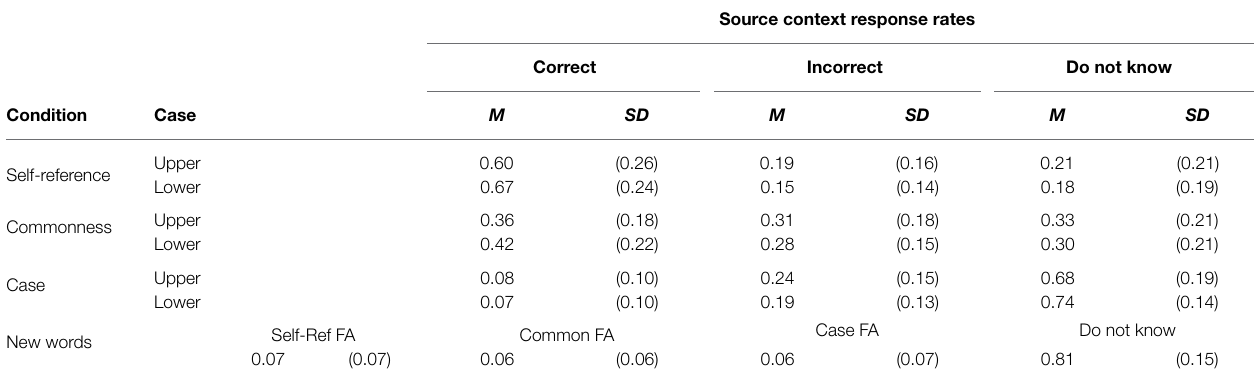
TABLE 2 | Source context memory (explicit